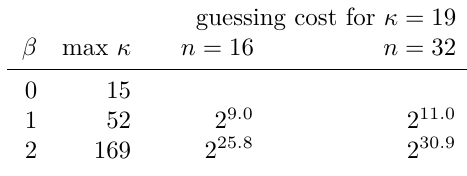
Table 6: The maximum possible κ handled by each guessing band size β for Kyber parameters and the cost of guessing the significant band.